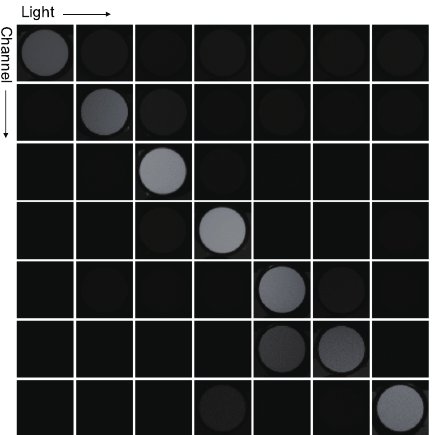
Figure 9. The obtained color mixing matrix for canceling channel crosstalk. The average brightness of white reflectance stardard becomes the color mixing matrix. The matrix will be diagonal matrix if there are no channel crosstalk, however non-diagonal element is slightly bright due to the channel crosstalk.